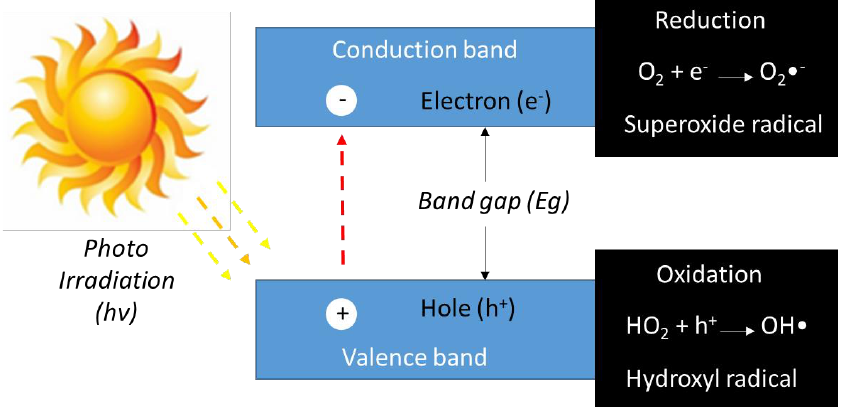
Figure 1. Schematic representation of semiconductor excitation by bandgap illumination generating photoelectrons in the conduction band and photo holes in the valence band.